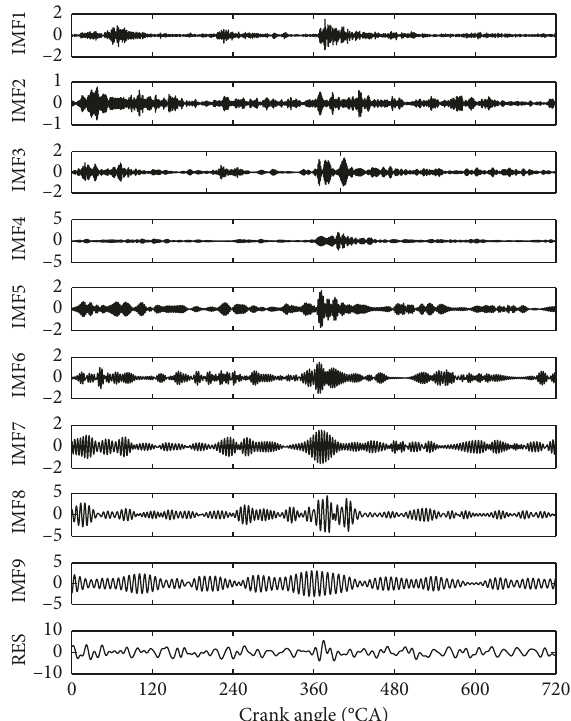
Figure 12: The decomposition results by the TVF-EMD method.